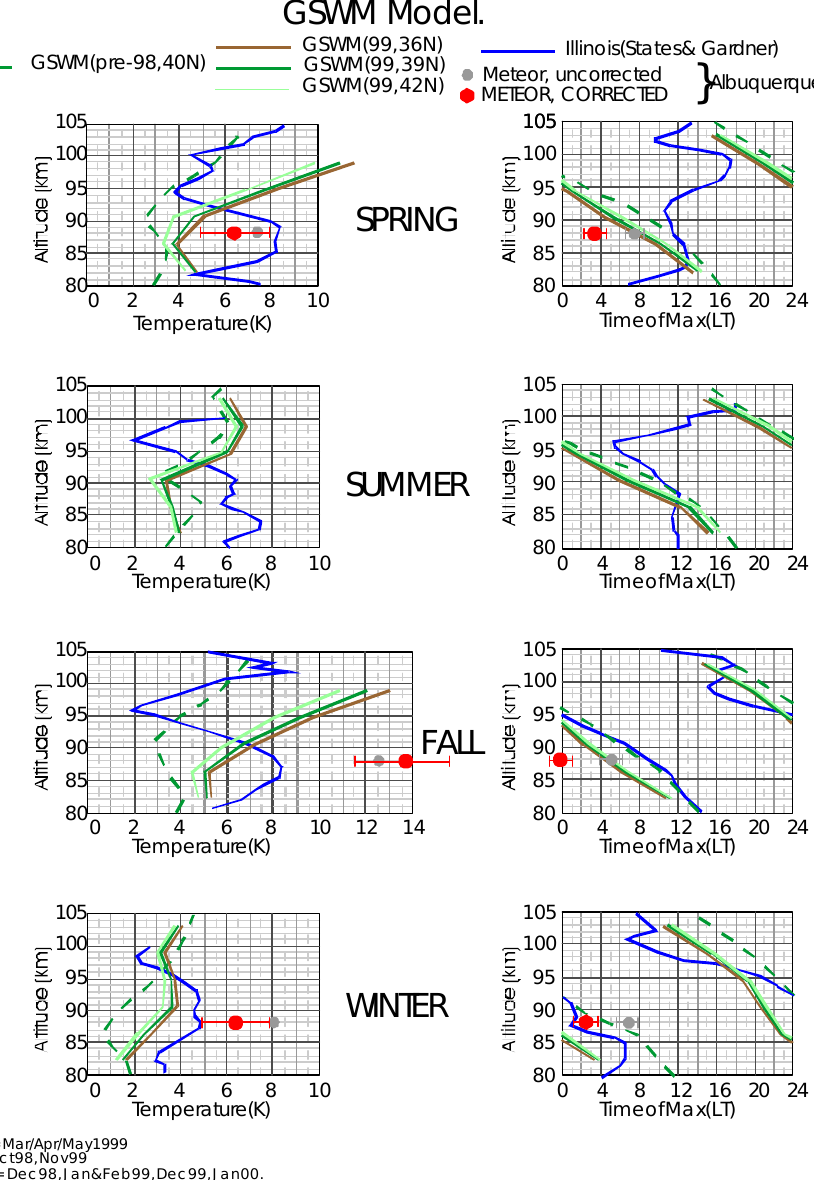
Fig. 4 c:\wkh\egs\mtidef04.cdr Fig. 4. Various estimates of the anticipated diurnal temperature tidal amplitudes and phases in the altitude band 35 to 42 ◦ N. Shown are estimates from the Global Scale Wave Model (Hagan et al., 1999), an earlier version of the GSWM, measurements due to States and Gardner (2000b), as well as two sets of estimates of diurnal temperature parameters made by meteor radar. The “uncorrected” meteor radar temperatures are also referred to as “naive” temperatures in the text, whereas the “corrected” temperatures are referred to as “true” temperatures in the text. Error bars are given for the “true” amplitudes, and for both true and naive phases. The error bars for the naive amplitudes are not given, but are the same as for the corresponding true